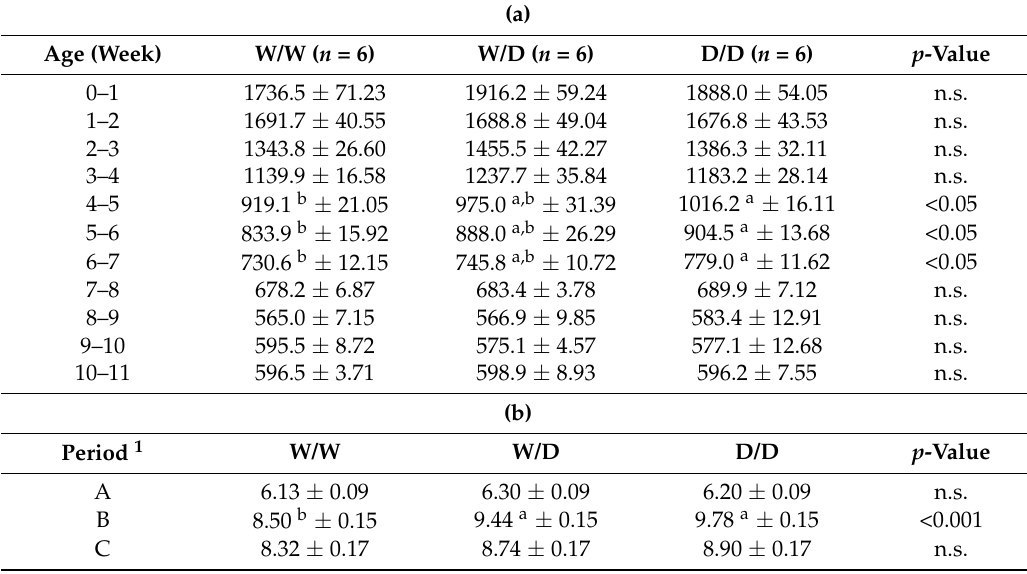
Table 2. Feed intake and growth rate of hens. (a) Feed intake of hens of different genotypes (g per kg body weight per week) (mean ± SEM); (b) growth rate (g/day) for Period A (Weeks 1 to 4), Period B (Weeks 5 to 7), and Period C (Weeks 8 to 11) (lsmean ± SEM, N =